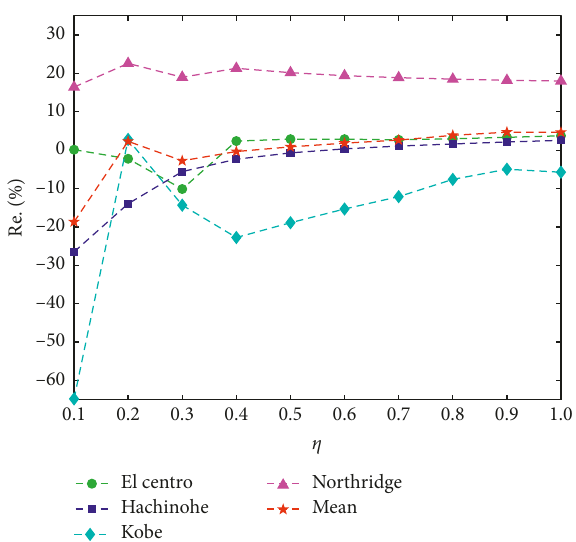
Figure 18: Reduction rates of structural maximum accelerations.